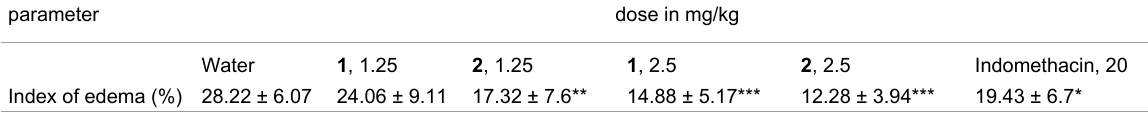
Table 5: Anti-inflammatory effect of compound 1 and 2 (intraperitoneal administration).